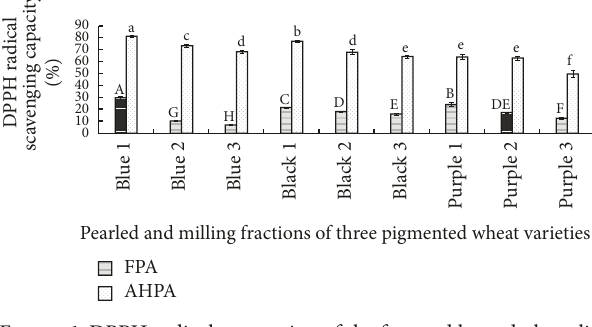
Figure 1: DPPH radical scavenging of the free and bound phenolic acids in the bran fractions of three pigmented wheat varieties. a Values are means of three determinations ± standard deviation, determinedbyHPLCanalysis. b Thesamelettersarenotsignificantly different ( 𝑃 < 0.05 ). Blue: blue wheat; Black: black wheat; Purple: purple wheat; 1: outer bran; 2: coarse bran; 3: shorts; FPA, free phenolic acid; AHPA, alkaline-hydrolysable phenolic